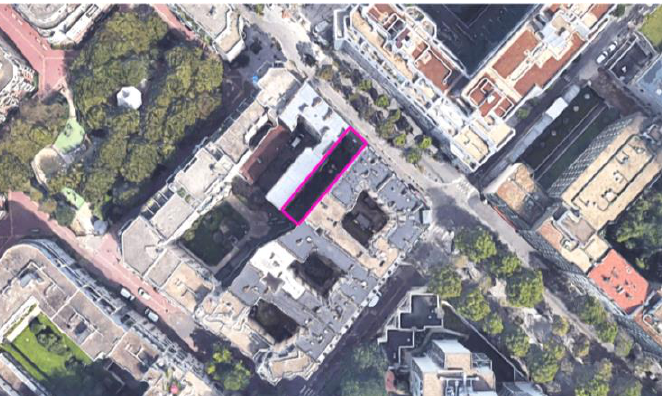
Figure 3. Location of the Passage 56 community garden in Paris, France — an elongated parcel of land in a residential quarter, [compiled by A. Nowysz, based on site visit (26.07.2016) and source: www.google.pl/maps, (accessed on 27 June 2017)].